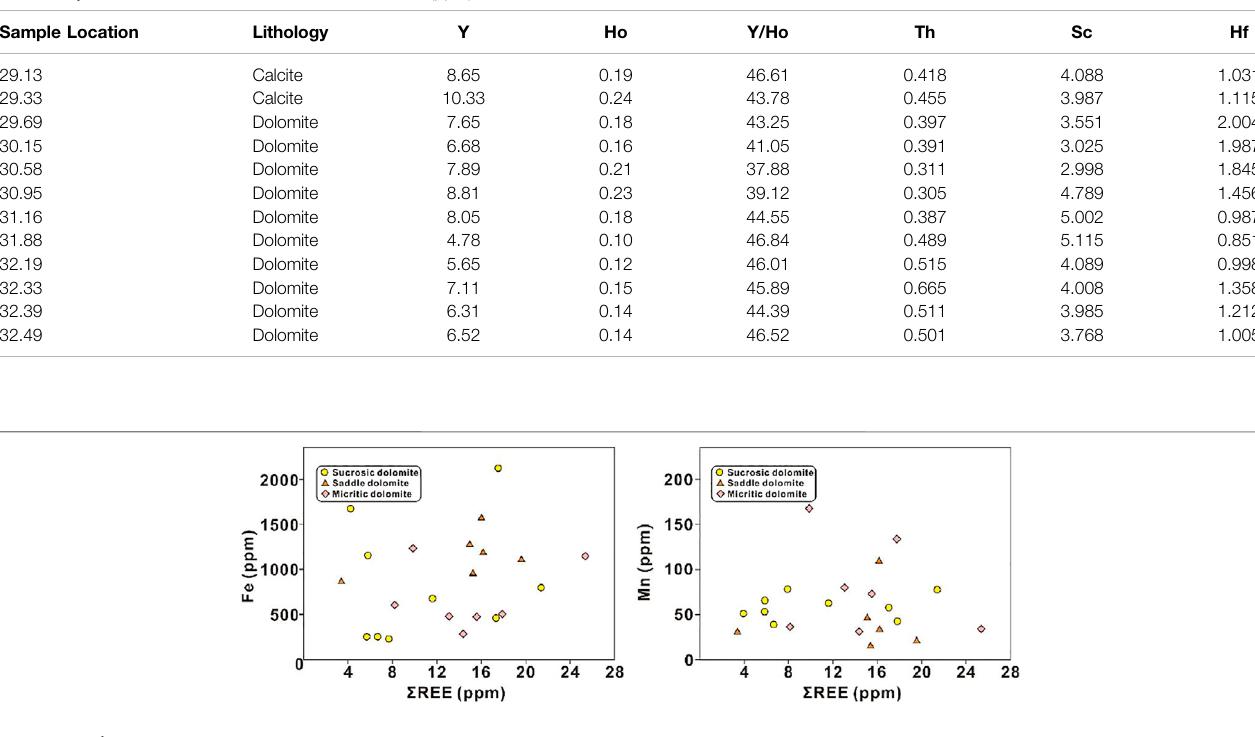
FIGURE 5 | Total rare-earth contents ( Σ REE) exhibiting random correlation with Fe/Mn concentrations.